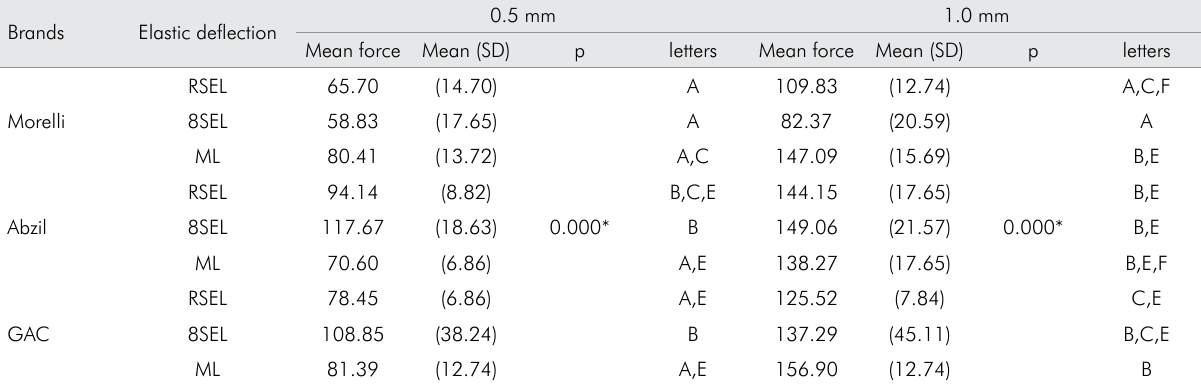
Table 4. Mean force (in centinewtons) and standard deviation (SD) of thermally activated 0.016-inch diameter Nickel-Titanium wires, from Morelli, Abzil and GAC brands with three different ligation types (ANOVA followed by Tukey tests). n = 10. Brands Elastic deflection